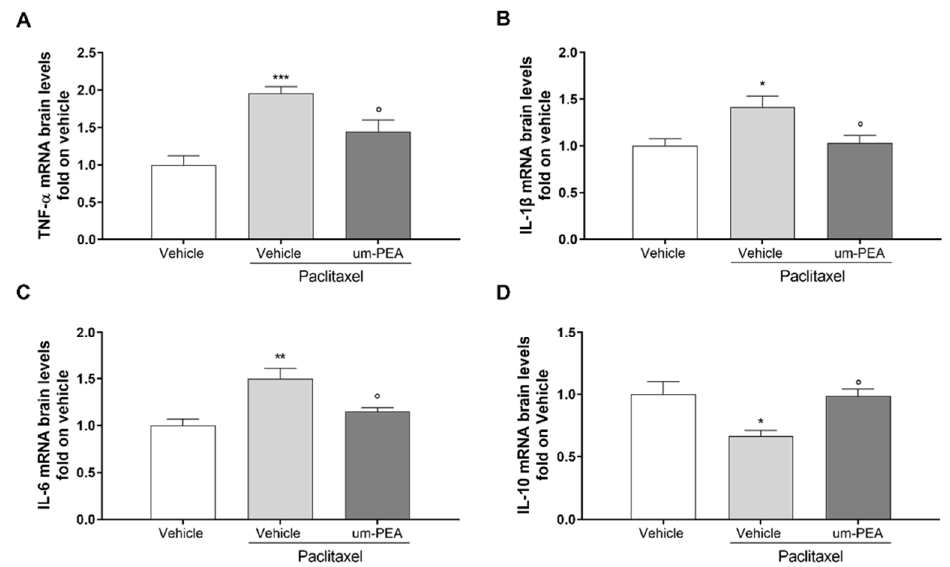
Figure 3. Pro-inflammatory cytokine levels in the hippocampi of vehicle- or um-PEA-treated mice injected with PTX. ( A ) Fold expression of mRNA for pro-inflammatory TNF- α ; ( B ) fold expression of mRNA for pro-inflammatory IL-1 β ; ( C ) fold expression of mRNA for pro-inflammatory IL-6; ( D ) fold expression of mRNA for anti-inflammatory IL-10; * p < 0.05, ** p < 0.01, *** p < 0.001 versus vehicle group; ° p < 0.05 versus PTX group. Data are presented as mean ± SEM ( n = 8). Differences were evaluated by ANOVA followed by Bonferroni’s post hoc test for multiple comparisons.